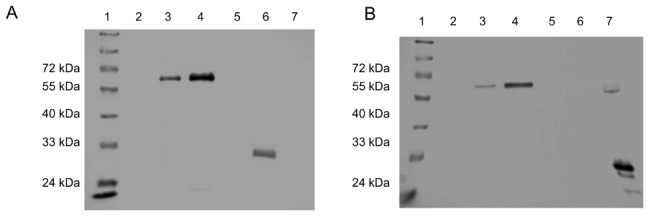
Western blots of antigen expressed by recombinant BCG.
A. Detection with anti-GFP antibodies. B. Detection with anti-p24 antibodies: Lanes; 1, molecular size marker; 2, pWB105; 3, pWB106; 4, pWB206; 5, pHS200; 6, pHS207; 7, purified recombinant p24 protein.